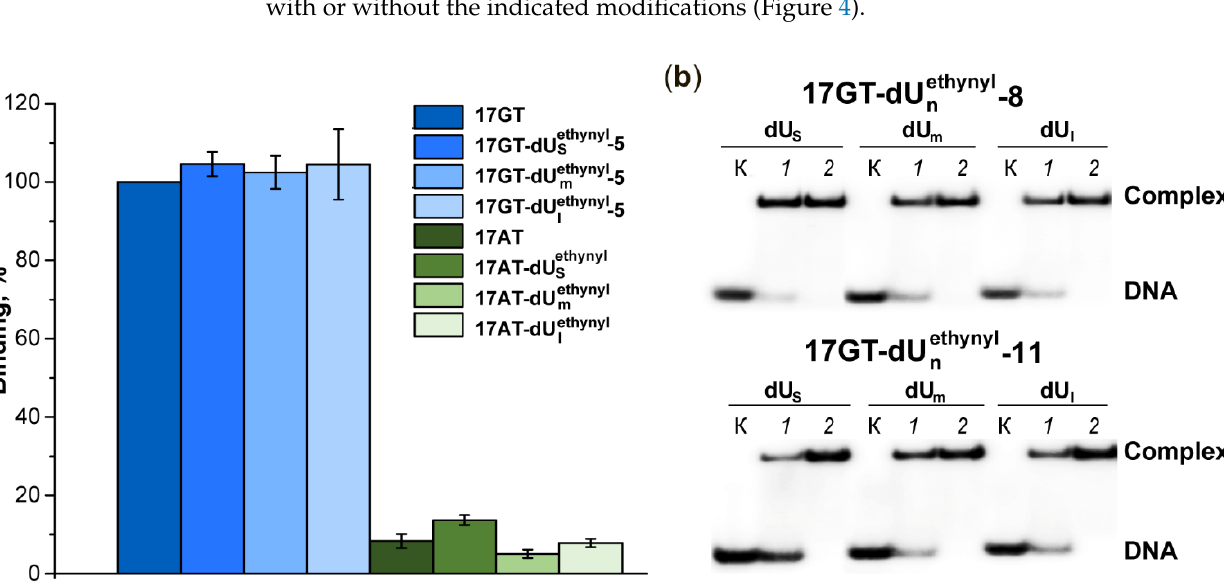
Figure 4. Binding of DNA duplexes to MutS(A469C). ( a ) Binding efficiency. Formation of the MutS(A469C) complex with an unmodified G/T-containing duplex is set to 100%. The standard deviation from the mean of at least three experiments is indicated; p < 0.05. ( b ) Analysis of complex formation between MutS(A469C) and 32 P-labelled duplexes 17GT-dU sethynyl -8 , 17GT-dU methynyl -8 , 17GT-dU lethynyl -8 (top panel), 17GT-dU sethynyl -11 , 17GT-dU methynyl -11 and 17GT-dU lethynyl -11 (bottom panel) by an electrophoresis mobility shift assay (EMSA). DNA concentration was 0.5 µM. MutS(A469C) concentration was 1 µM (a, lanes 1 ) or 2.5 µM (lanes 2 ). Lanes K correspond to DNA without the protein. Autoradiograph of a 6% polyacrylamide gel.